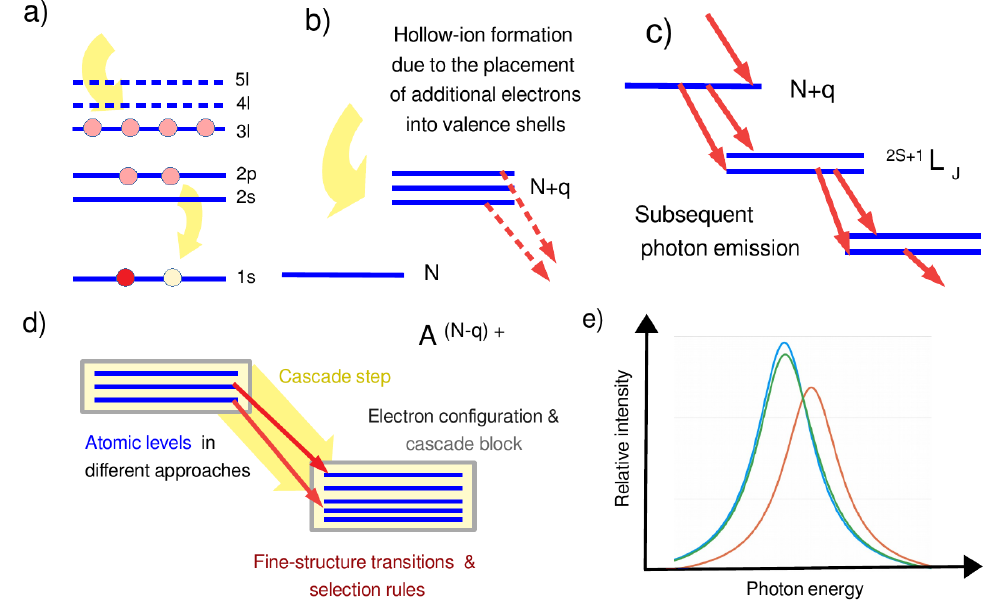
Figure 1. Photon emission of multiply excited ions following the placement of additional electrons into outer n (cid:96) shells. ( a ) Single-particle view upon capture of one or several electrons into the L 23 and M shells of initially hydrogen-like ions. ( b ) Associated many-particle view upon the formation of excited ions with q additional electrons in different n (cid:96) shells, and where ( c ) each electron configuration with a well-defined population of the shells gives rise to a multiplet of terms and fine-structure levels 2 S + 1 L J (blue lines) as well as to photon transitions (red arrows) that connect these levels. ( d ) Modeling of photoemission cascades from such hollow ions in terms of electron configurations, fine-structure multiplets (cascade blocks) and transition amplitudes based on the well-known selection rules, and which alltogether determine the observed photon emission. ( e ) Schematic shift and broadening of, for example, the K α 12 lineshape owing to additional electrons in n (cid:96) valence shells. See text for further